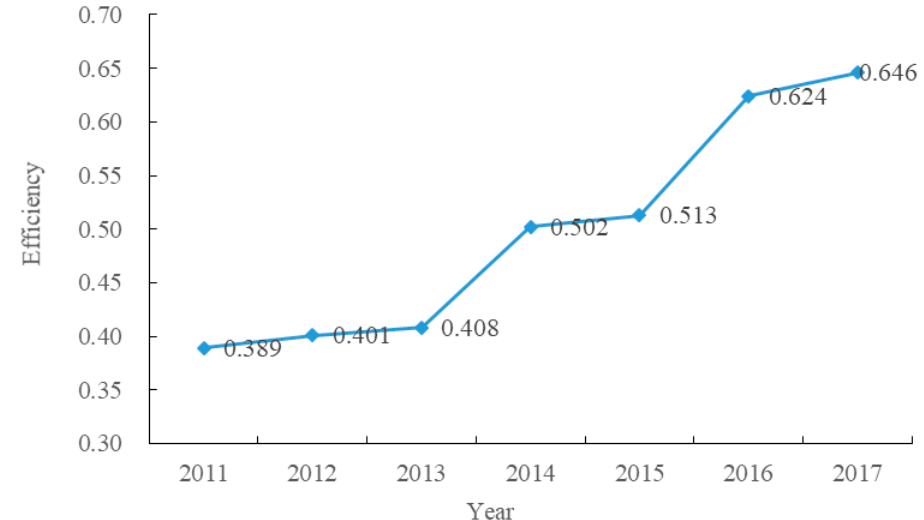
Figure 2. The rural LRAE at county scale of the study area from 2011 to 2017.